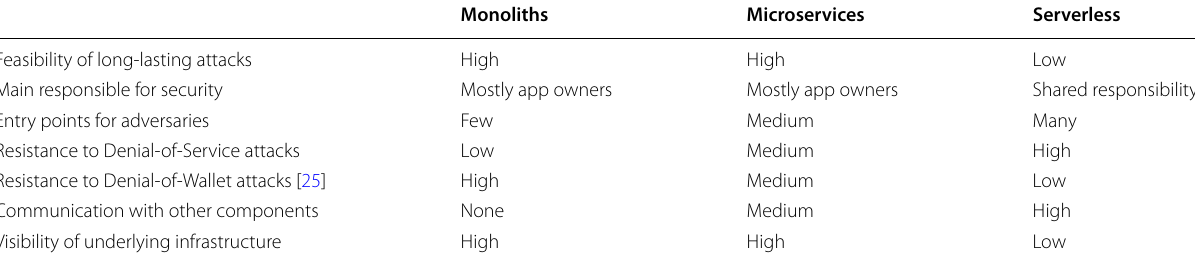
Table 1 Security comparison between monolithic applications, microservices, and serverless—in serverless, we consider security to be a shared responsibility because many of the responsibilities that software developers used to have are now shifted to cloud